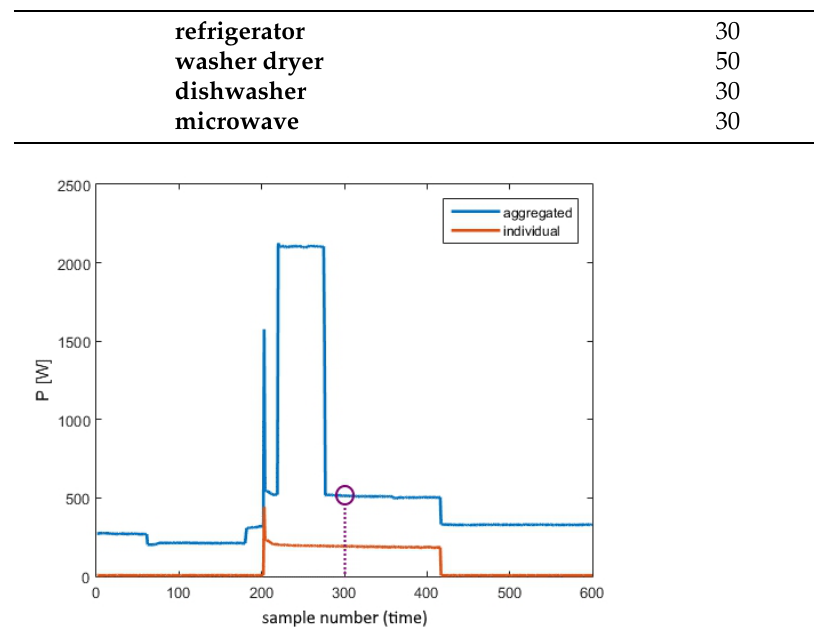
Figure 6. Example of label-defining for the